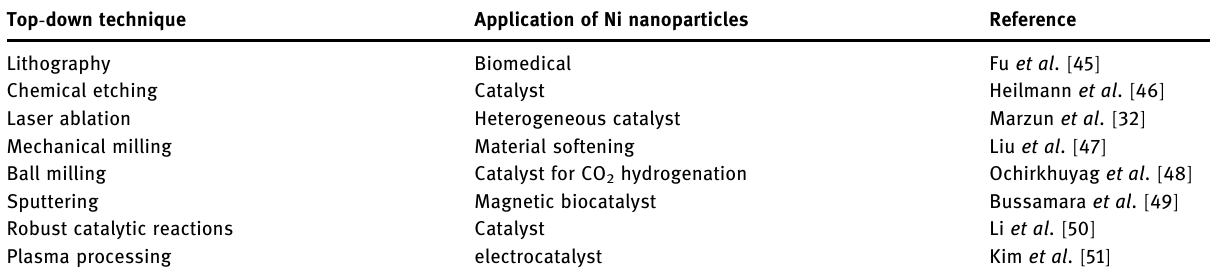
Table 1: Top - down techniques for the fabrication of Ni nanoparticles Top - down technique